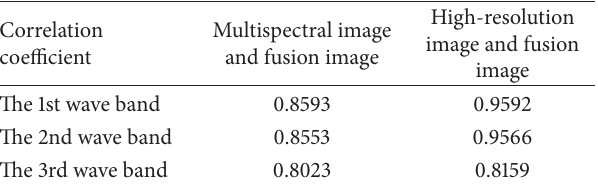
Table 6: Combined method based on energy selection and wavelet transform.